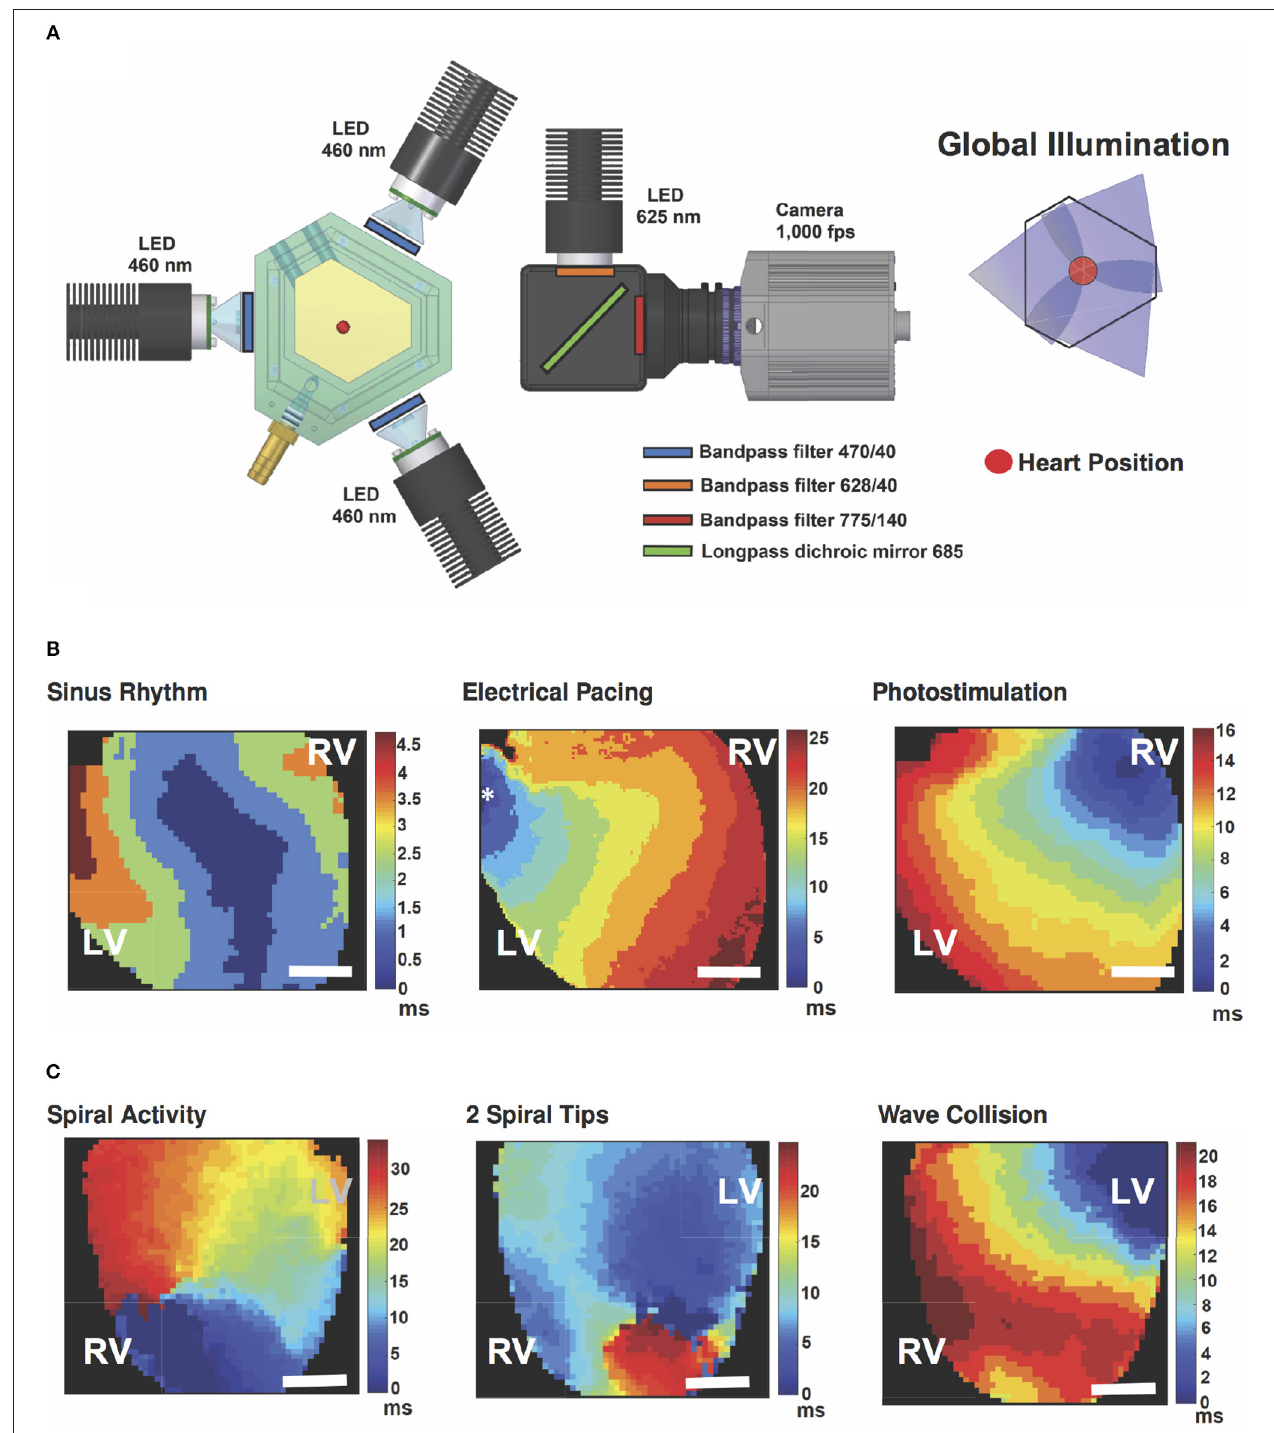
FIGURE 1 | Global illumination and optical mapping setup. (A) The heart is perfused in a bath surrounded by three blue-LED for panoramic photostimulation. Light of a 625nm LED is reflected via a dichroic mirror onto the heart surface. Emission was recorded through a 775 ± 70nm bandpass filter and an EMCCD camera at 1kHz. Global illumination is reached via overlapping light cylinders. (B) Activation maps in posterior view of the heart of spontaneous sinus rhythm and stimulation examples electrically (electrode position is marked with an asterisk) as well as by global illumination. (C) Exemplary activation maps in anterior view of the heart of induced cardiac arrhythmia and collision of waves leading to annihilation of arrhythmic pattern. Color-bars indicate activation time in ms and the scale-bars mark 2mm. A movie of the wave collision is available as ( Supplementary Material Movie 1 ). LV - Left Ventricle, RV - Right Ventricle.